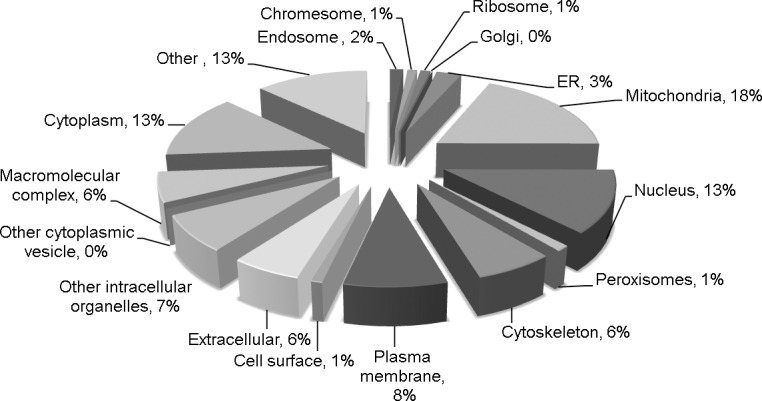
Detection of reversible cysteine thiol oxidation with TMT switch and mass spectrometry.Cellular compartment pie chart of 1017 proteins containing TMT-tagged cysteine thiols.